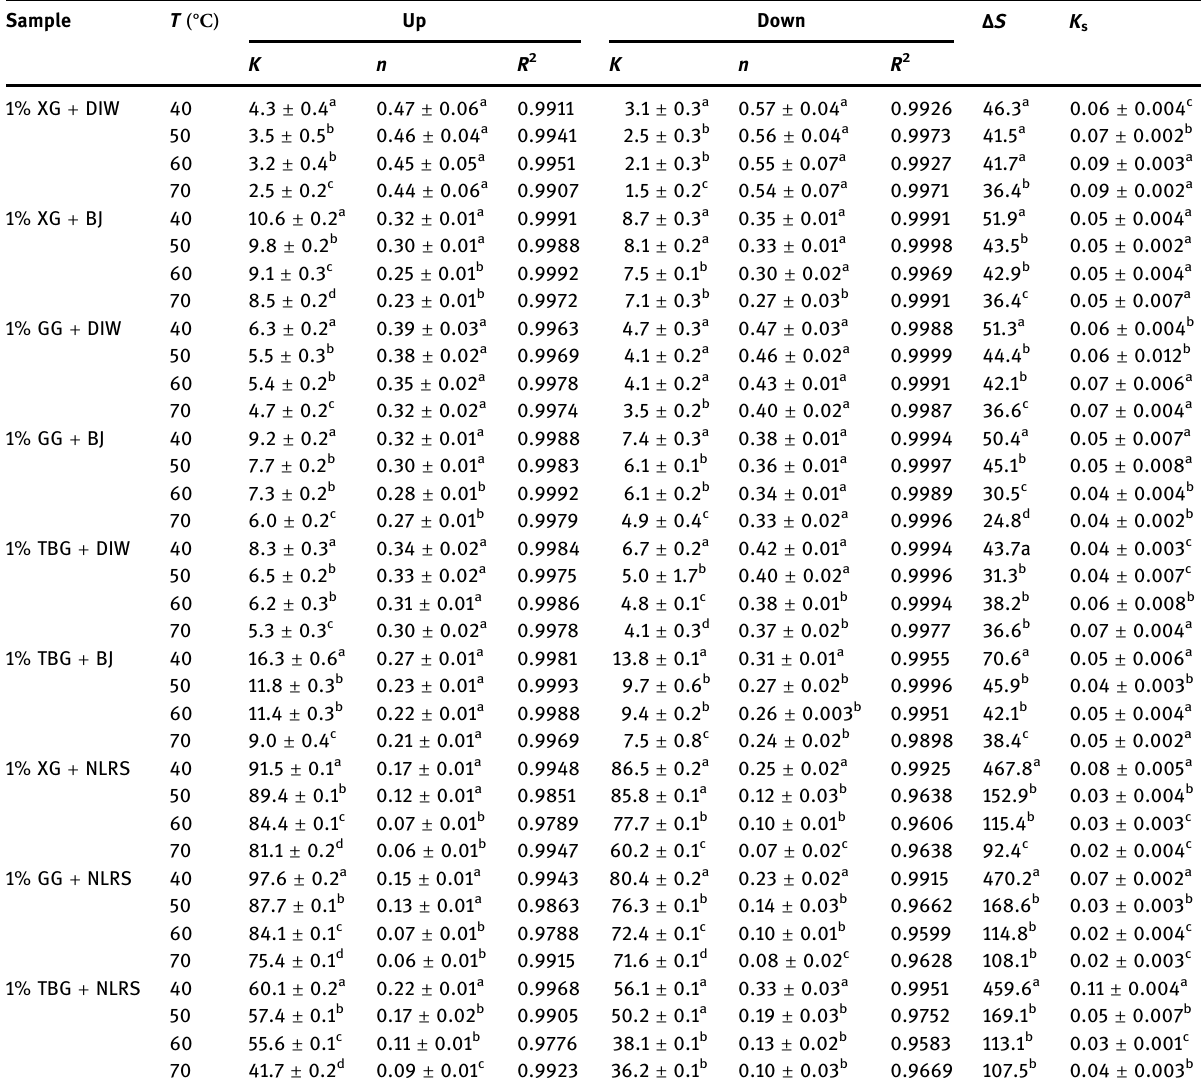
Table 4: E ff ect of temperature on Ostwald – de Waele parameters and hysteresis loop area Sample T ( ℃ )